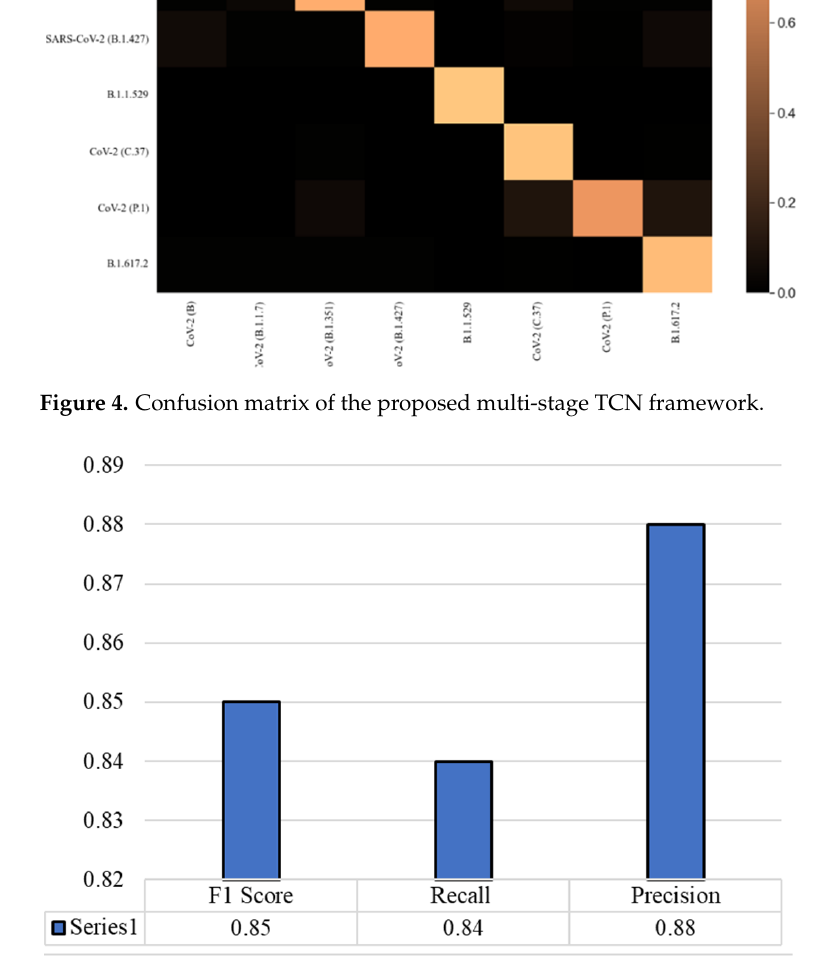
Figure 5. Recall, F1 score, and precision of the proposed model.